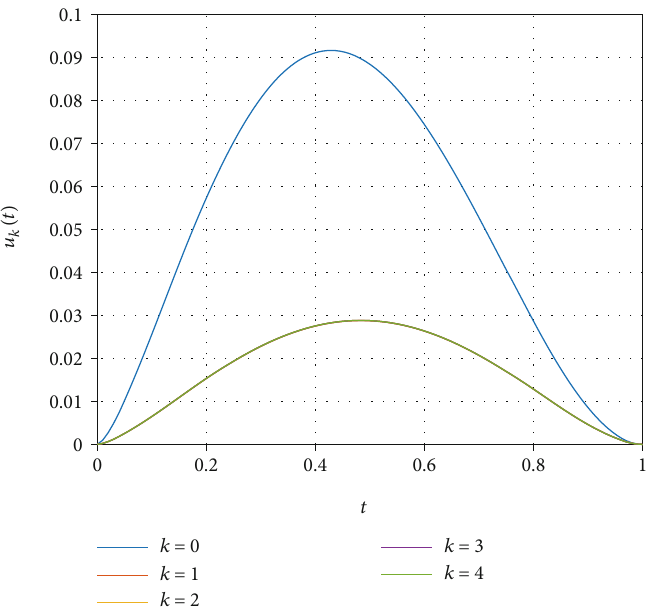
Figure 1: The approximation of the solution of problem (35).